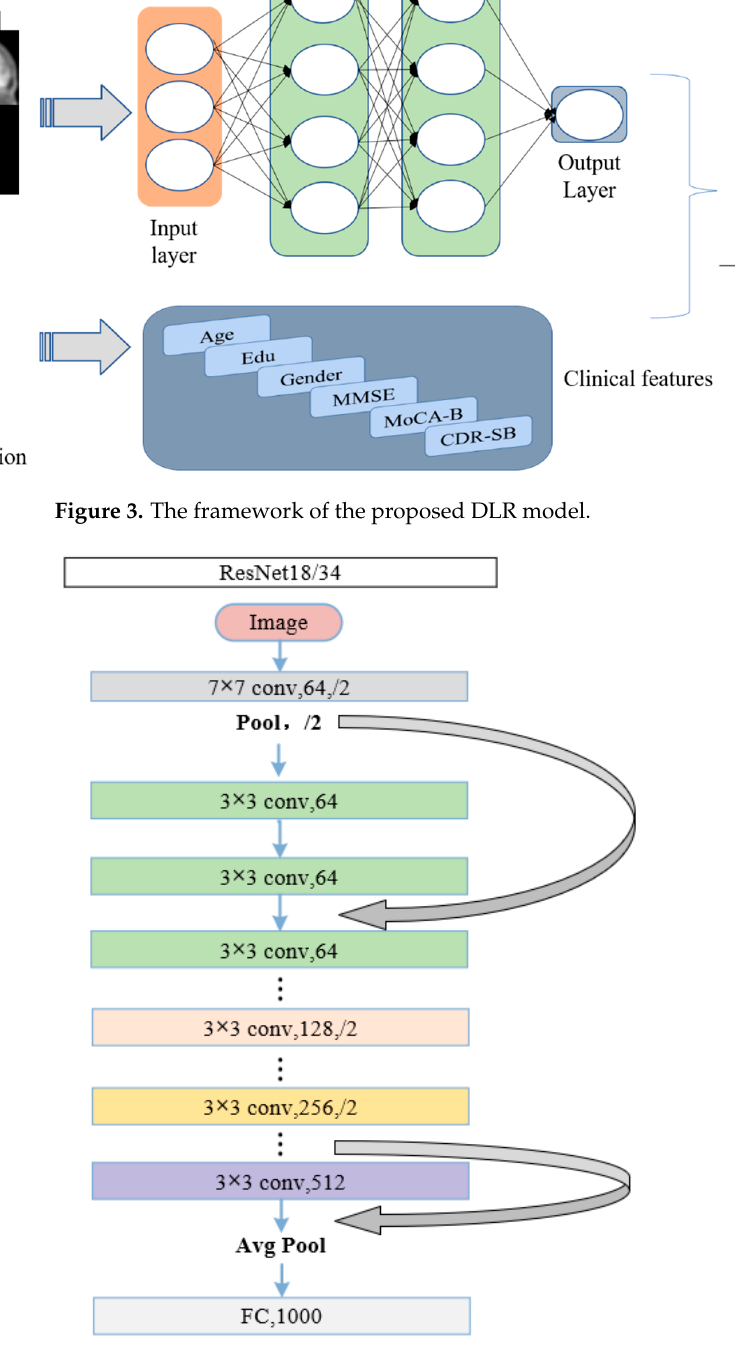
Figure 4. The fundamental structure of ResNet18 and ResNet34. “7 × 7” and “3 × 3” indicate the size of the convolution kernel, “conv” indicates convolution, “Avg Pool” indicates average pooling, and “FC” indicates fully connected layer. “64”, “128”, “128”, “256” and “512” represent the numbers of channels, and “/2” means stride of 2.